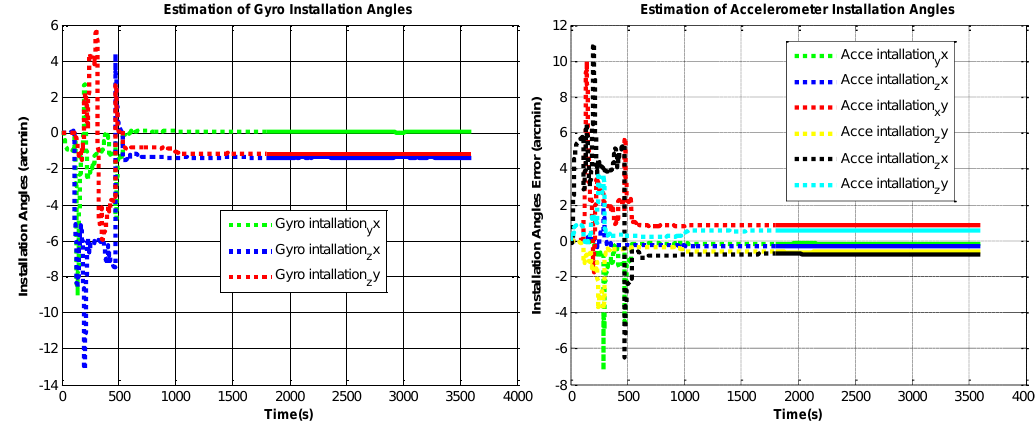
Figure 8. Estimation curves of gyroscope and accelerometer installation angle errors.